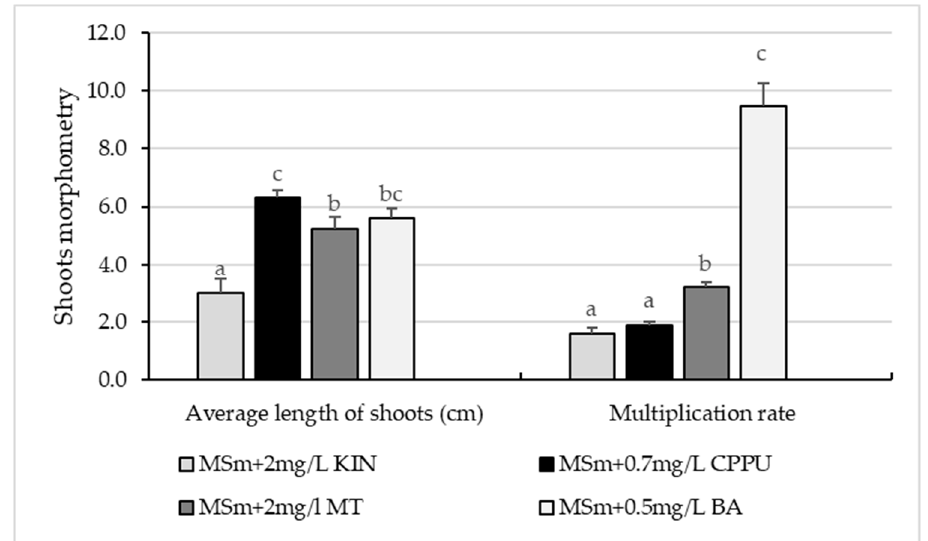
Figure 1. Effect of different types and concentrations of cytokinins on shoots’ proliferation in H. lupulus cv. Cascade after 8 weeks of in vitro culturing. Different lowercase letters above the bars indicate significant differences between the means of the same parameter according to Tukey’s HSD test ( p < 0.05).